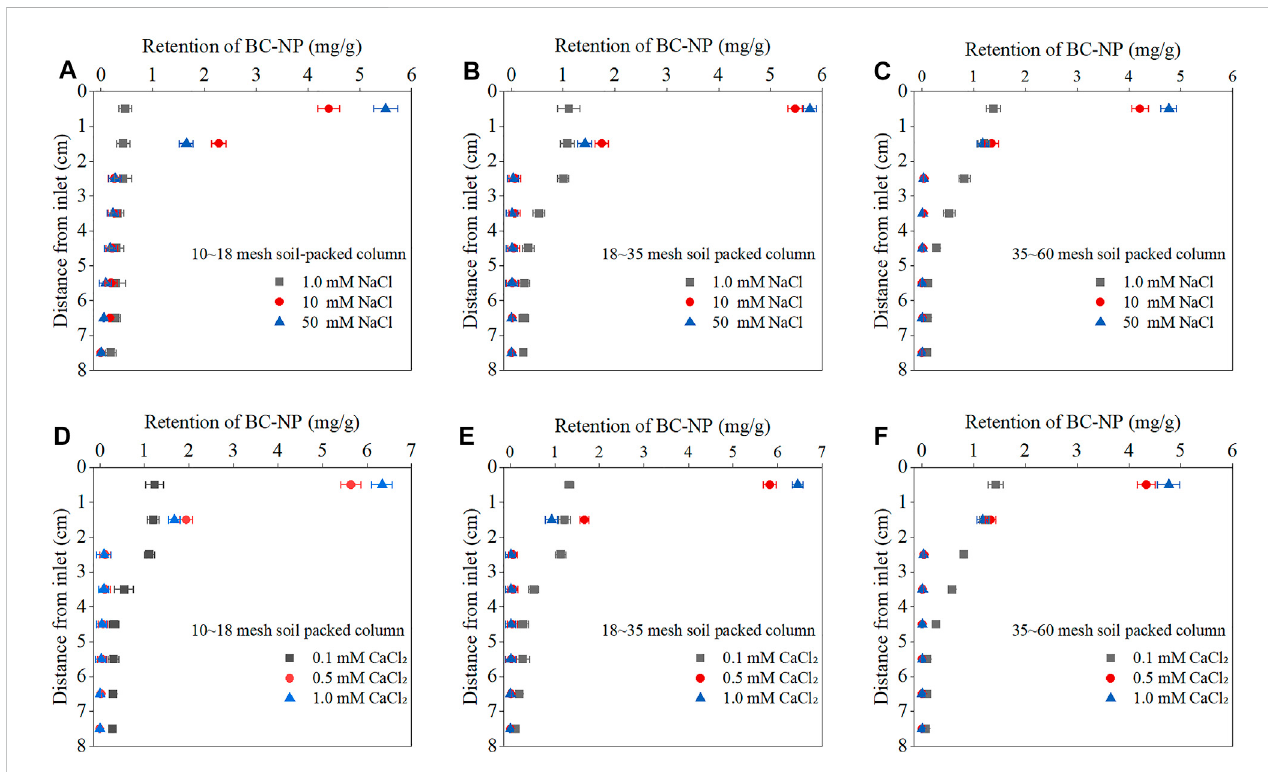
FIGURE 4 Retentioncurvesofbiocharnanoparticles(BC-NP)asafunctionofcolumndepthfromthecolumninletatvaryingconcentrationsofNaCl[1.0,10,and50 mM; (A – C) ],CaCl 2 [0.1,0.5,and1.0mM; (D – F) ]inpackedcolumnswithdifferentsoilgrainsizes(10~18,18~35,35~60mesh).Errorbarsrepresentthestandard deviation of means ( n =